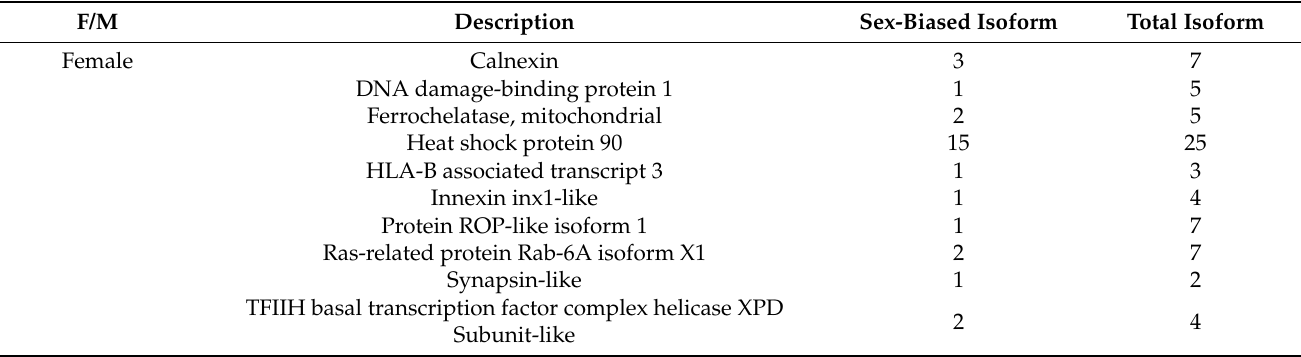
Figure 4. Heatmap of sex-biased expressed genes involved in top two enriched Gene Ontology (GO) terms. Heatmaps were generated for female-specific transcripts ( A ) and male-specific transcripts ( B ). Each line represents a transcript annotated by BLAST, and the color scale indicates relative expression level by transcripts per million (TPM) values. Table 1. Selected candidate genes with sex-biased expression in the Artemia franciscana